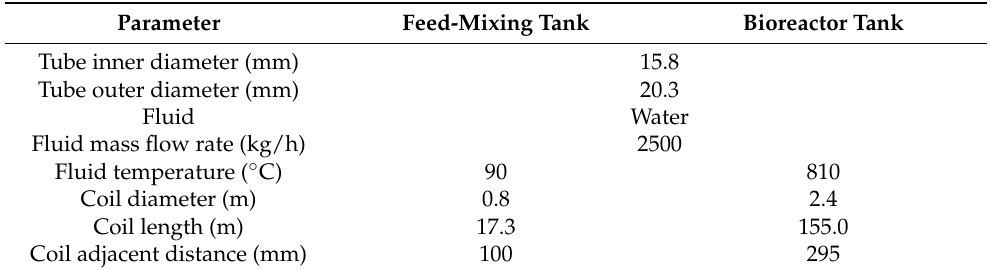
Table 5. Operating parameters for the coil heat exchanger for the feed-mixing and bioreactor tanks.